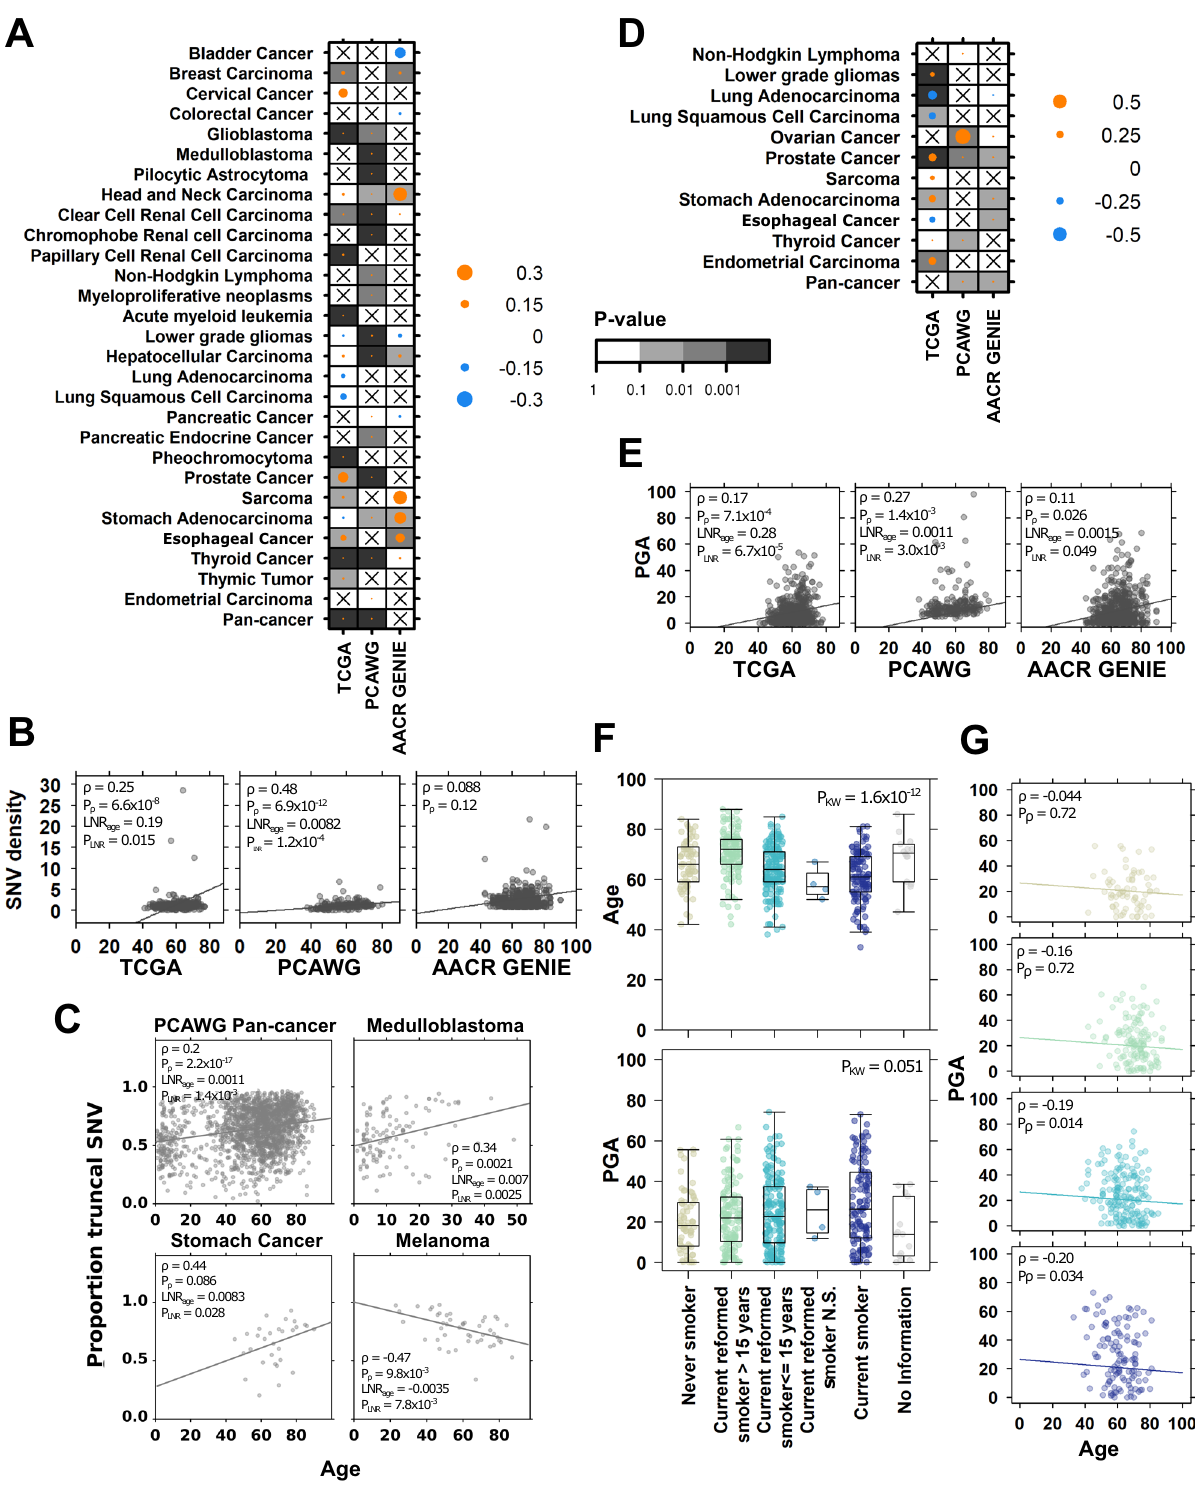
Table 2 for the fi ve tumour-types with consistent evidence in at least two datasets. To better understand why lung cancers of younger patients might have higher genomic instability, we investigated tobacco use. Tobacco exposure is a well-known risk factor in lung